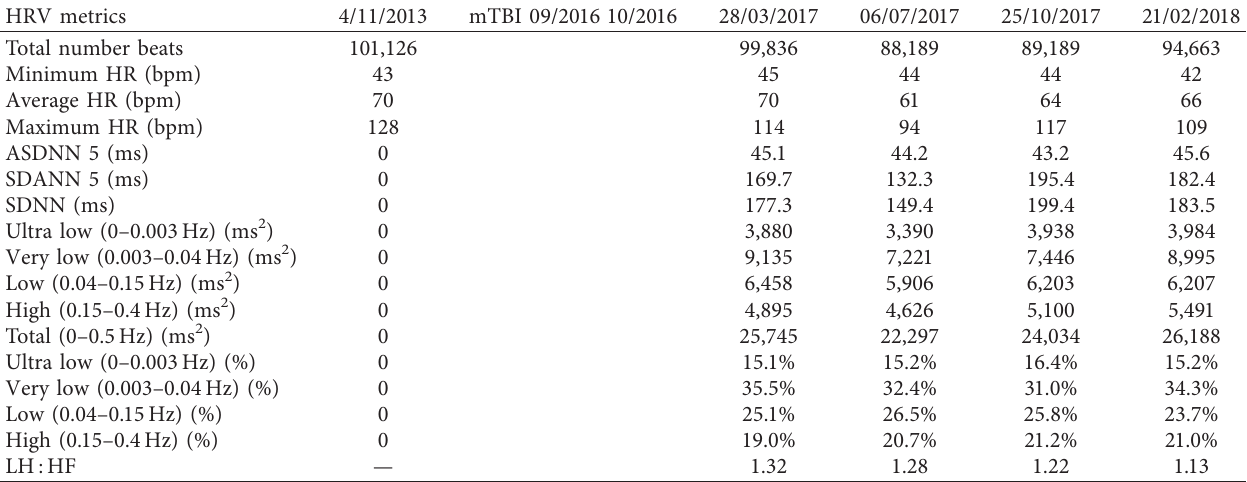
Table 2: Heart rate and heart rate variability (HRV) data from the 24-hour Holter monitor from April 2013 to October 2018. HRV metrics